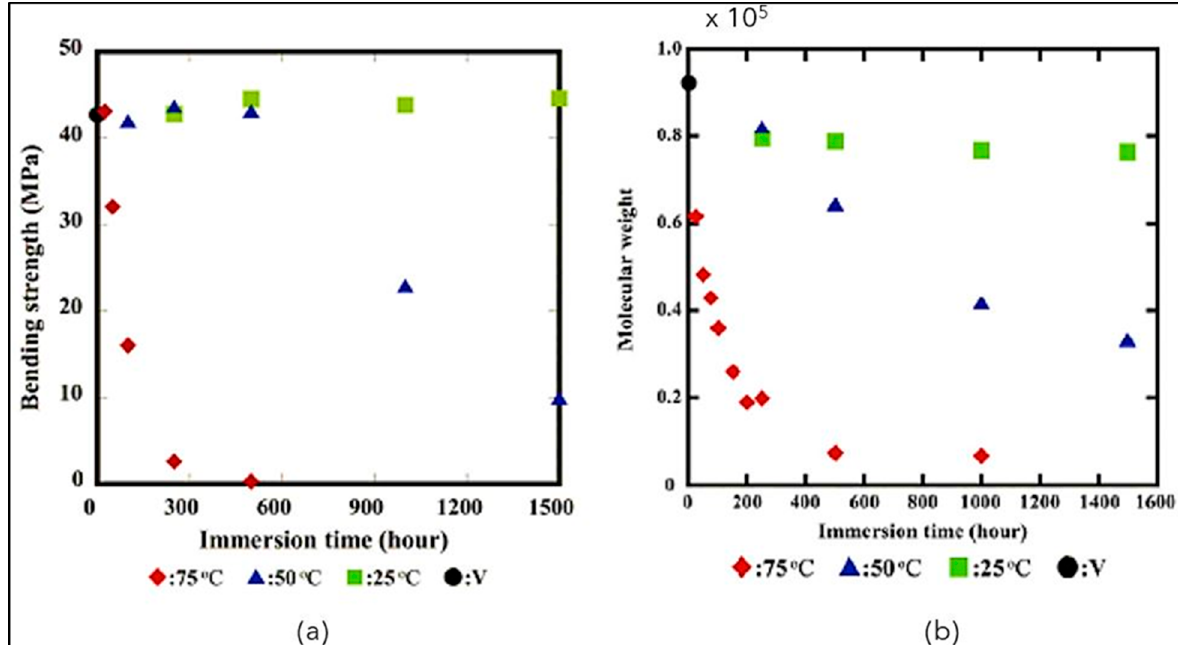
Figure 9. ( a ) Bending strength and ( b ) Molecular weight of PBS vs. immersion time at different temperatures [Reprinted with permission from Reference [139] Copyright 2012 Elsevier].